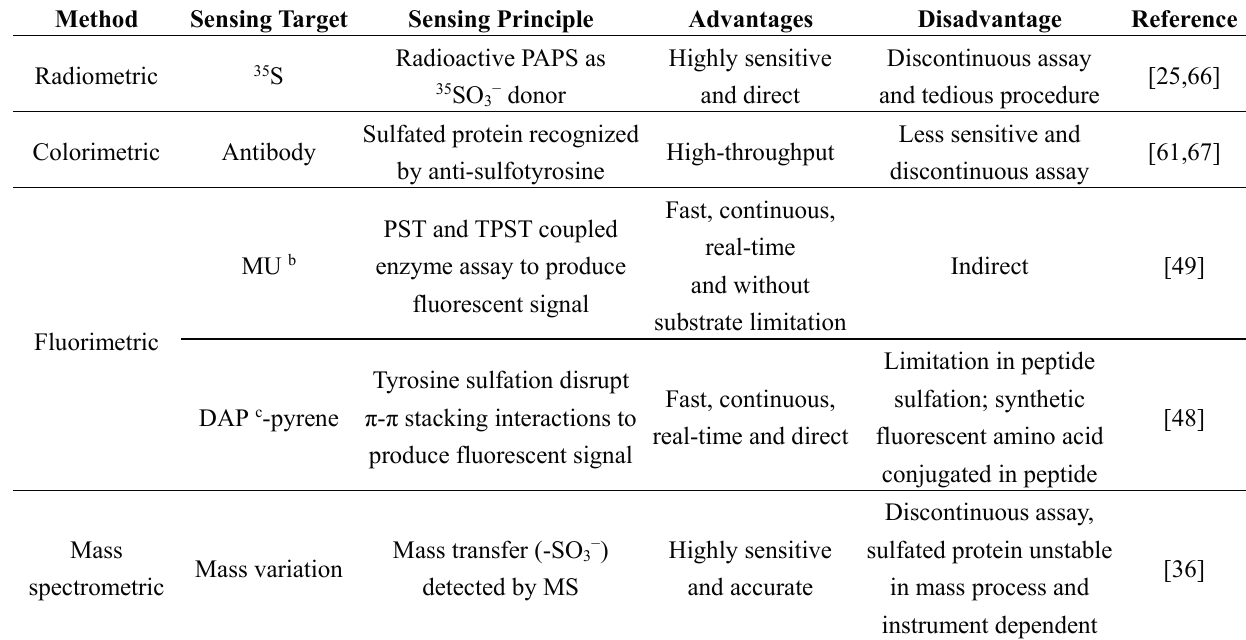
Table 2. Methods for the assay of TPST activity and the detection of PTS a